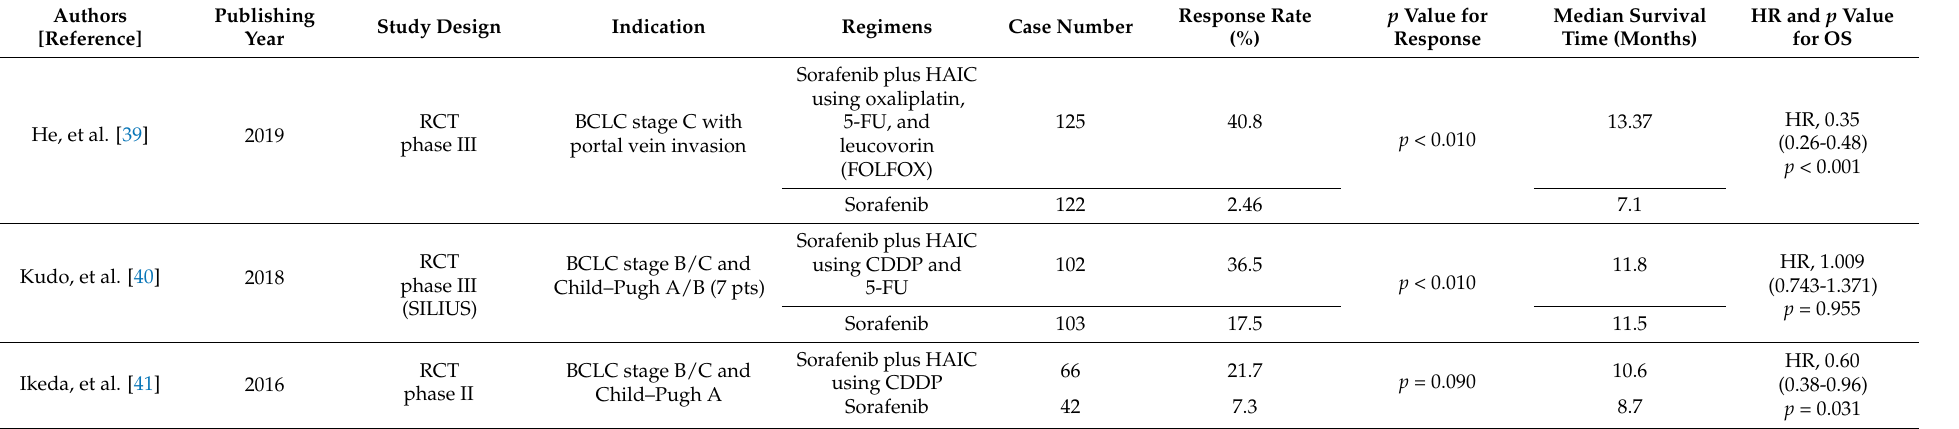
Table 3. Randomized controlled trials comparing sorafenib plus hepatic arterial infusion chemotherapy with